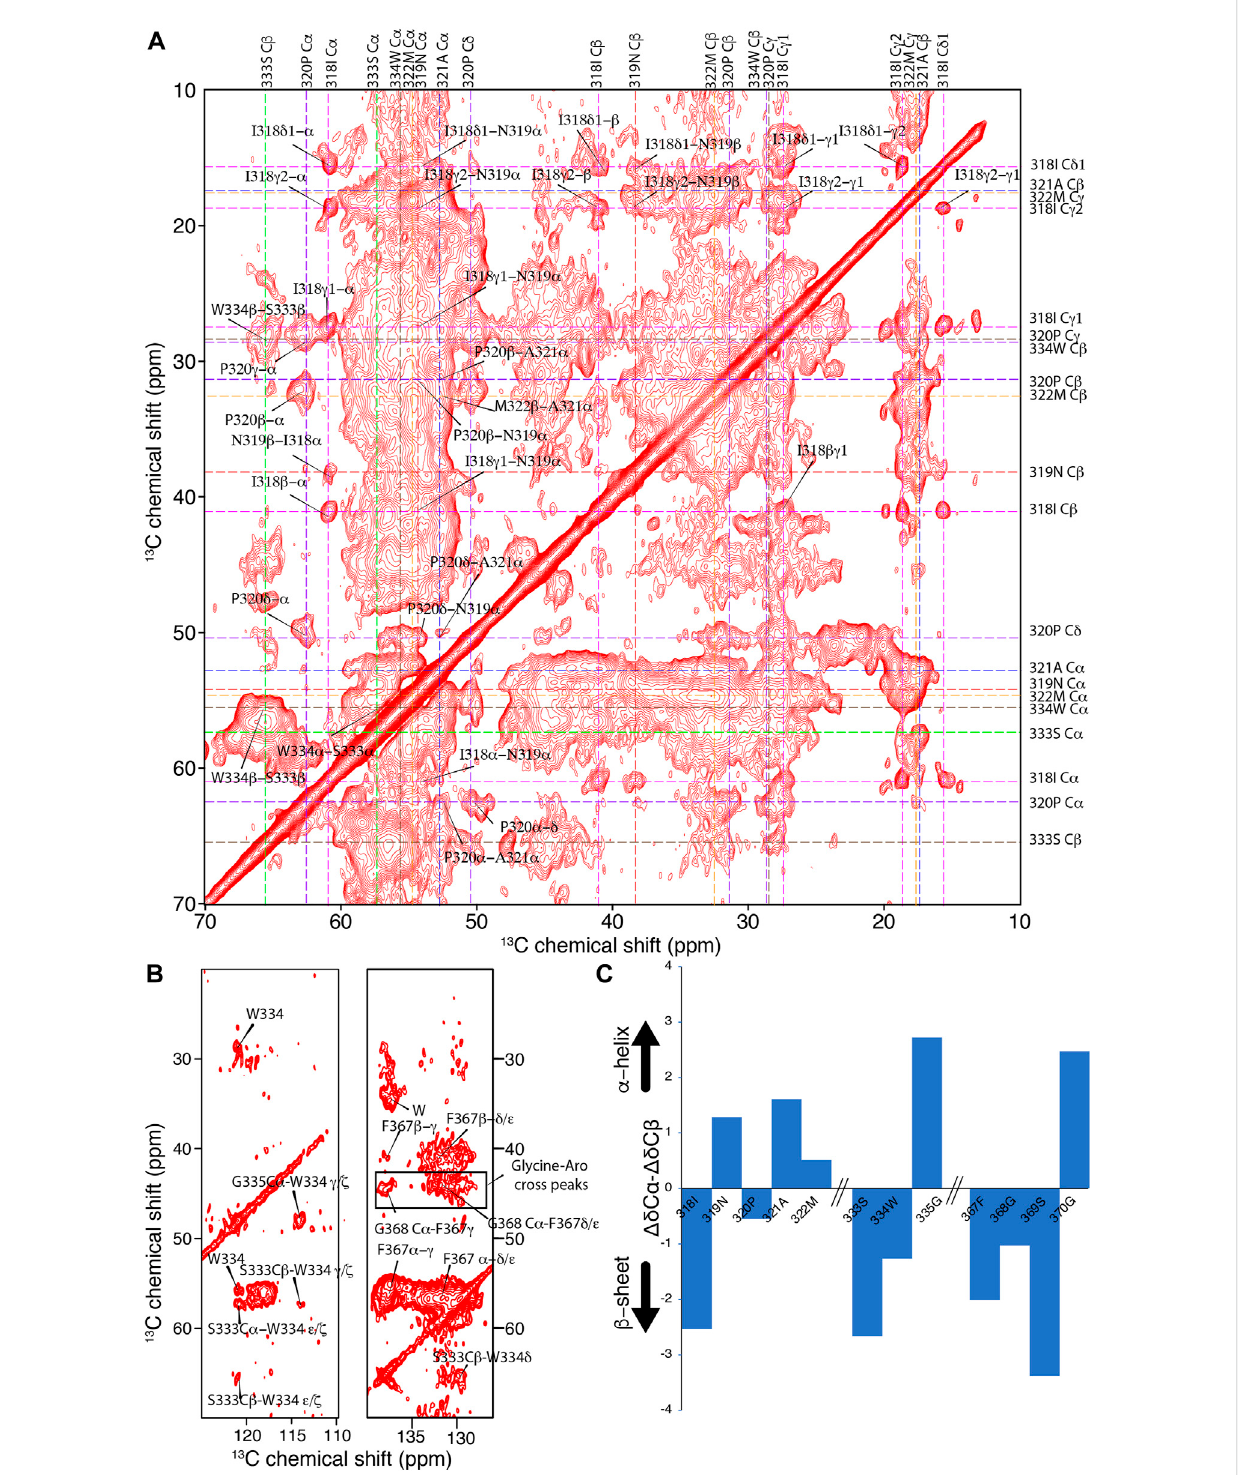
Investigation of the amyloid core of TDP-13 amyloid aggregates. (A) Aliphatic and (B) aromatic region of 2D 13 C – 13 C correlation experiment of TDP- 13 amyloid aggregates recorded at a 1 H frequency of 800 MHz at 278 K and 11 kHz MAS. A PDSD mixing time of 150 ms was used to favor sequential (i.e., residue i to i ± 1) connectivity indicated by color-coded dotted lines. (C) The secondary chemical shift analysis of stretches 318 – 322, 333 – 335, and 367 – 370 comparing experimentally obtained chemical shift with that of random-coil conformation using the equation Δδ C α – Δδ C β (Wang and Jardetzky, 2002). Positive and negative values corresponds to α -helical or β -strand conformation,